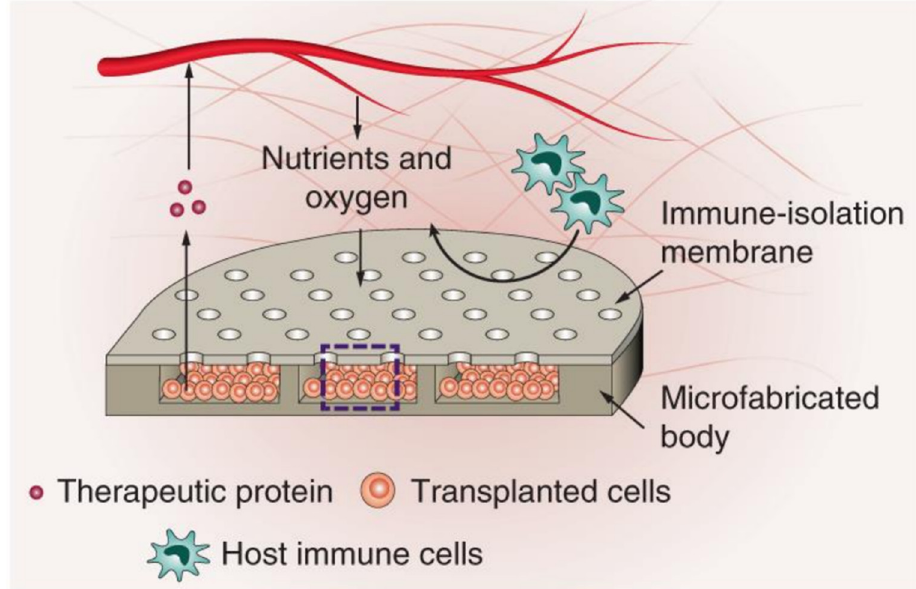
Figure 5. Design and working principle of a biocompatible device housing therapeutic cells. The cells are embedded in alginate microgels allowing for the intake of nutrients and oxygen, removal of waste and secretion of therapeutic proteins while keeping the host’s immune cells from entering the device. The figure has been reproduced with permission from Springer Nature [78].